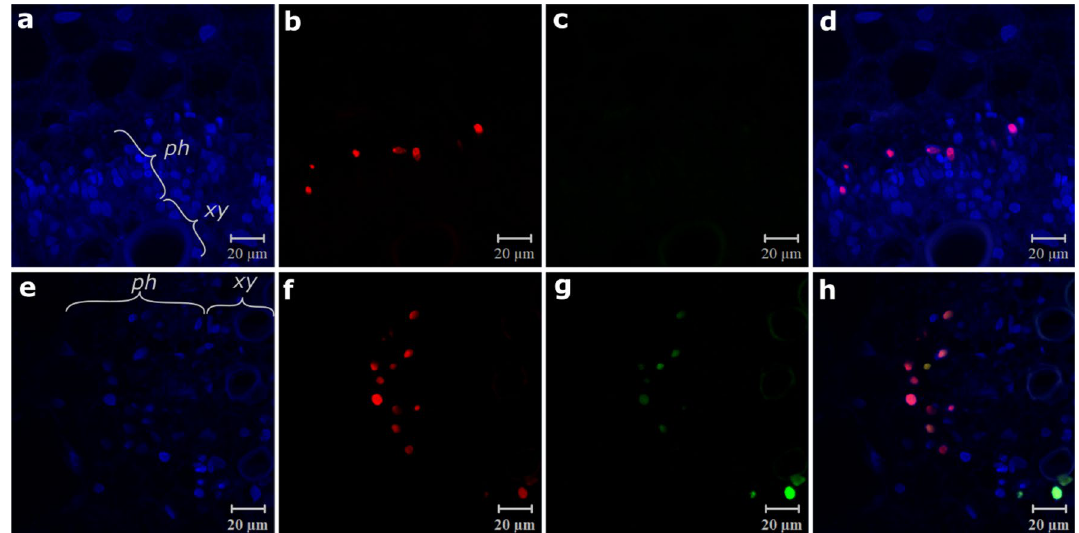
Figure 4. Location of PepYVMLV DNA-A in single ( a – d ) or mixed ( e – h ) infection with DNA-B in cross sections of infected tomato petioles. DNA-A ( b , f ) and DNA-B ( c , g ) components revealed by red and green FISH probes, respectively. Nuclei are stained with DAPI blue. Images ( d , h ) in which the three channels (blue, red, and green) are merged enable identification of the components located together in the cell nuclei. Phloem (ph) and xylem (xy) bundles are indicated. Mean number of infected cells per cross section of petioles DNA-A and/ dpi Infection NCSPA DNA-A DNA-B DNA-A and -B or